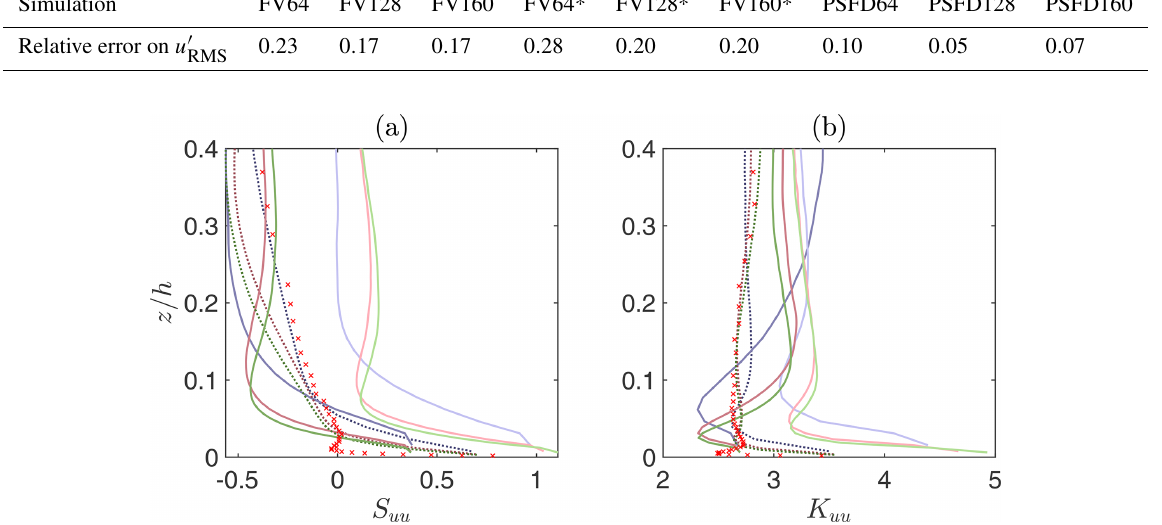
Figure 2. Vertical structure of skewness of streamwise velocity (a) and kurtosis of streamwise velocity (b) . Lines are defined in Fig. 1. The red x-marks denote the measurements from Monty et al. (2009), digitalized by the